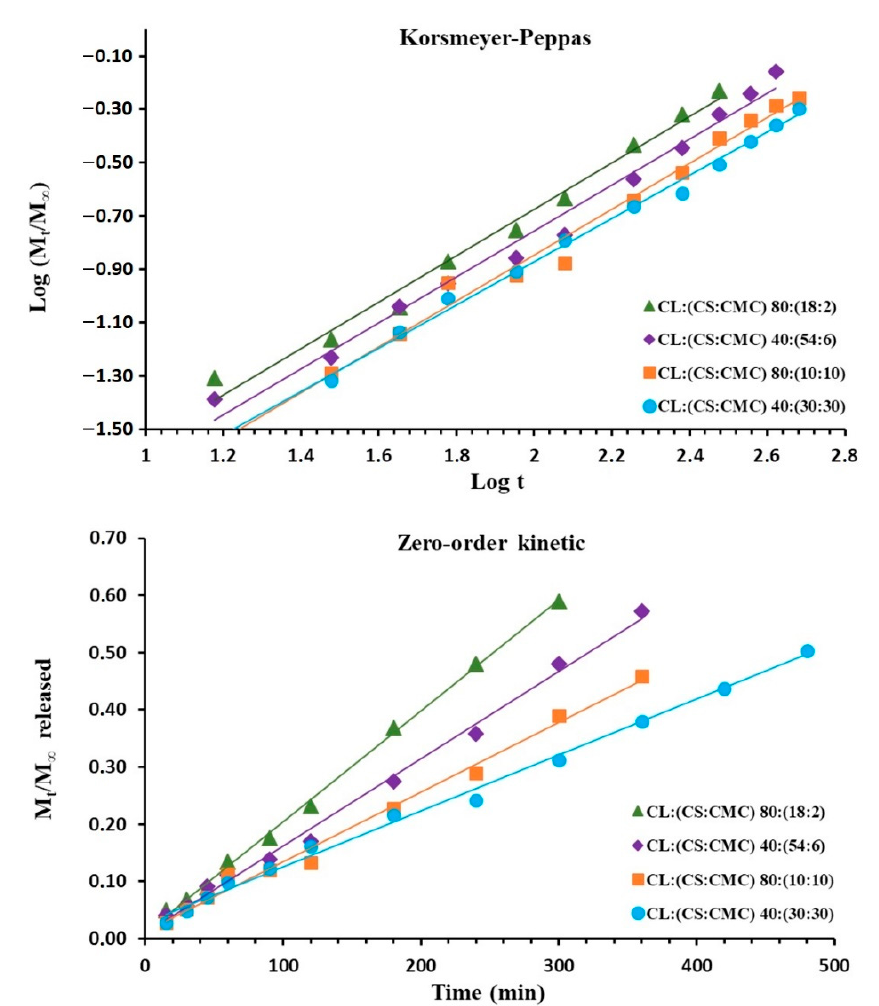
Figure 6. Korsmeyer-Peppas and zero-order kinetic models applied for clarithromycin release from PEC tablets CL:(CS:CMC) 80:(18:2), 40:(54:6), 80:(10:10), and 40:(30:30). The zero-order kinetic model of PEC tablets with low CS/CMC interactions, CL:(CS:CMC) 80:(18:2) and 40:(54:6), showed the highest R 2 values (0.9983 and 0.9944 respectively), followed by the Higuchi kinetic model (R 2 values of 0.9629 and 0.9465), as